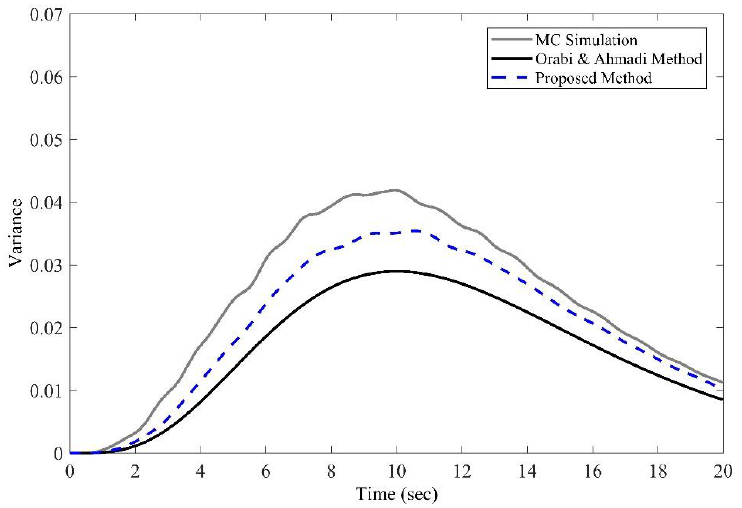
Figure 9. Mean square displacement response due to nonstationary excitation. ( γ = 10.0, μ = 10.0).